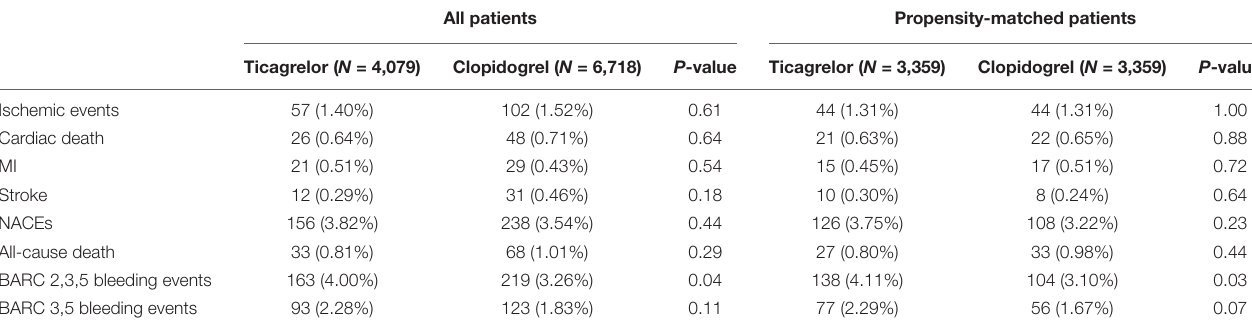
TABLE 3 | Clinical outcomes over 12 months between clopidogrel and ticagrelor in the low-risk groups before and after propensity score matching. All patients Propensity-matched